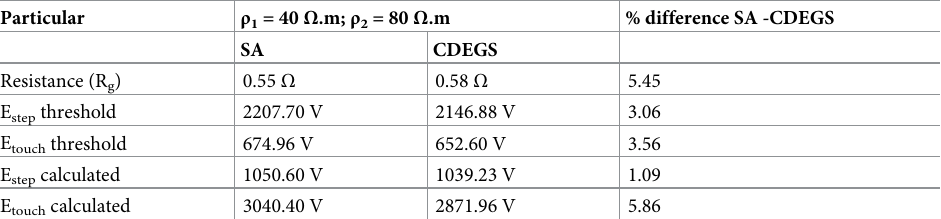
Table 10. Results for grounding system in horizontal two-layer soil ( ρ 1 < ρ 2